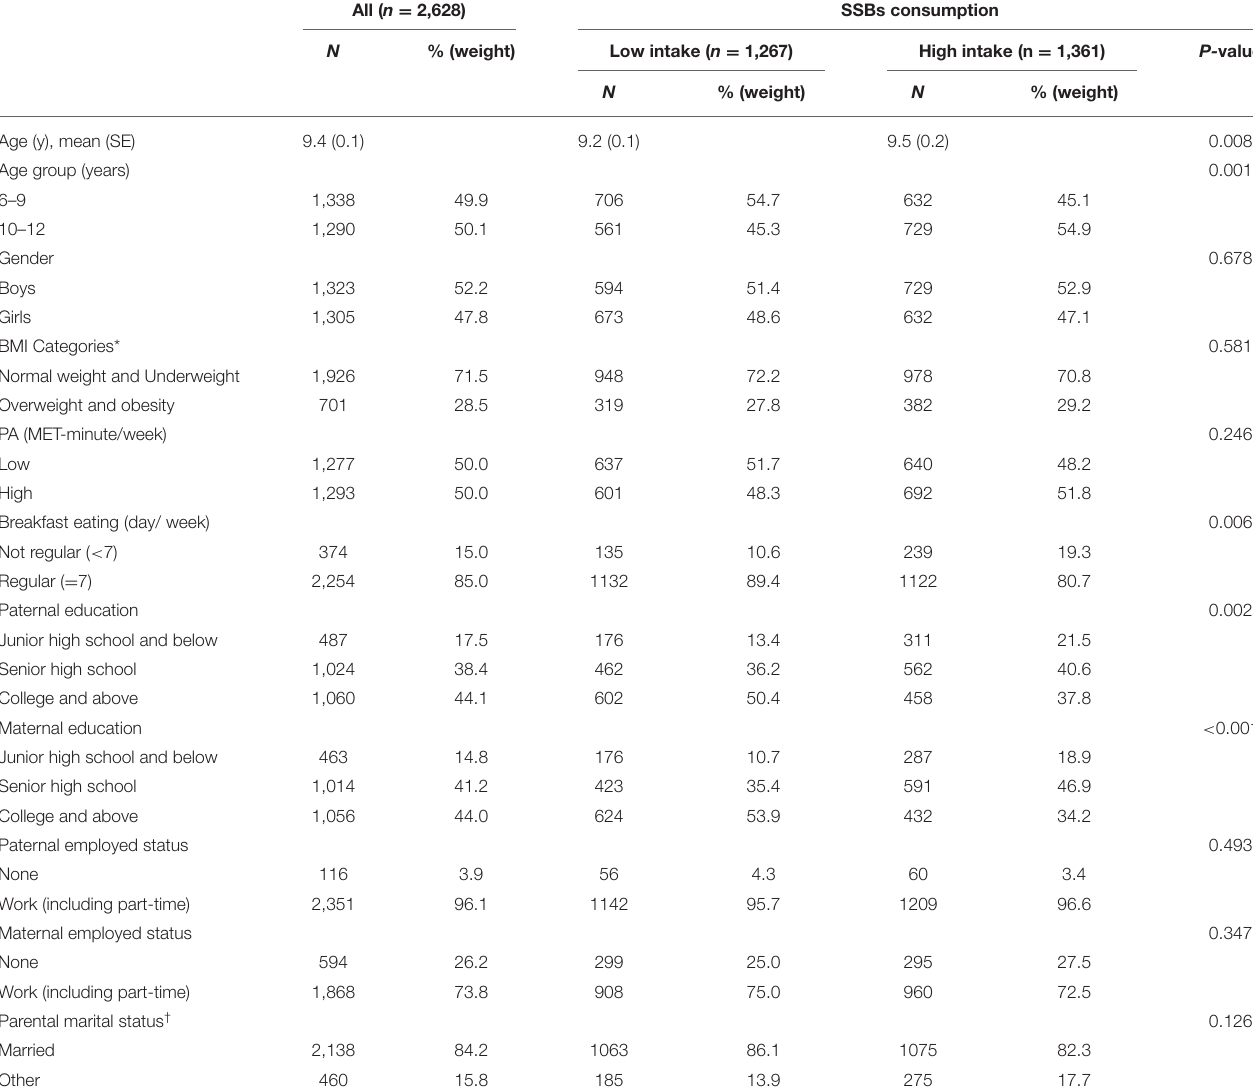
TABLE 1 | Characteristics of sampled children aged 6–12